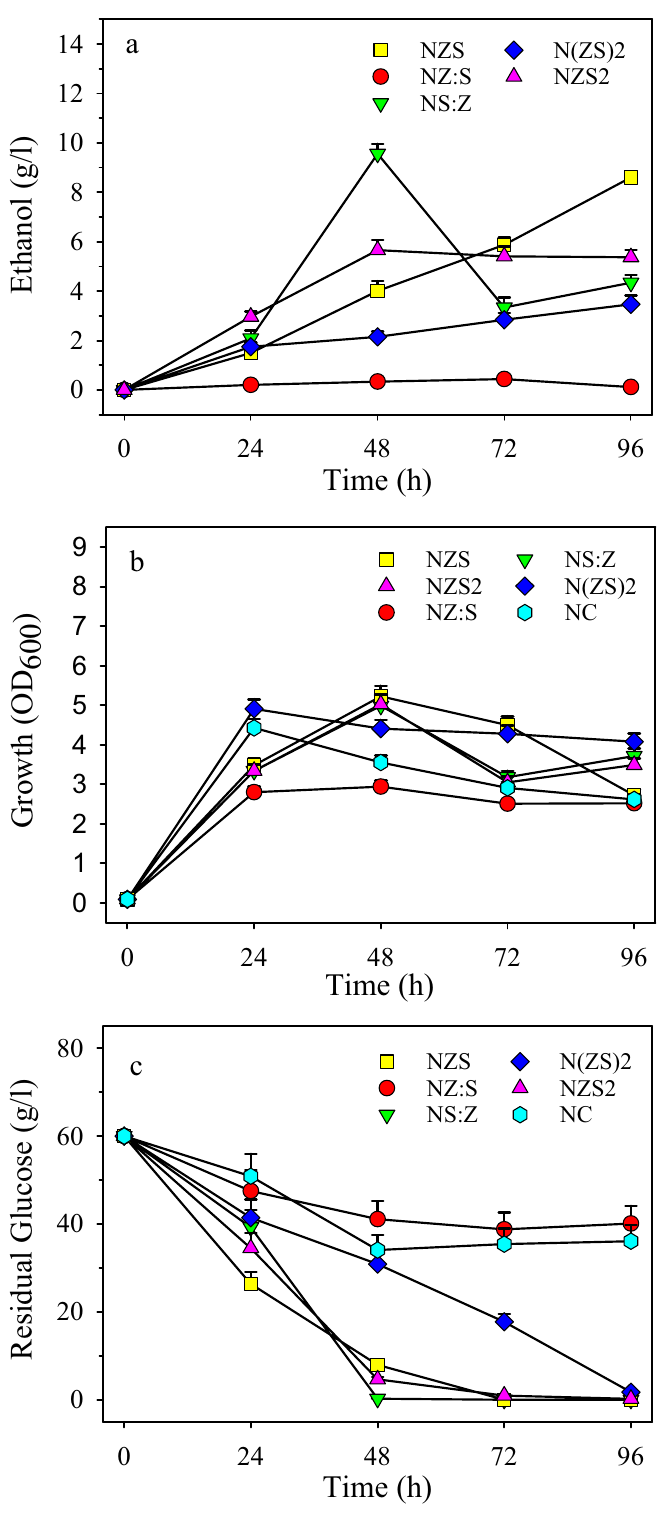
Figure 6. Ethanol production by B. subtilis strains harboring different numbers of pdc Z and adh S as well as fusions of the genes. Strains NZS (Δ ldh , pdc Z -adh S ), N(ZS)2 (Δ ldh , ( pdc Z -adh S ) 2 ), NZS2 (Δ ldh , pdc Z - ( adh S ) 2 ), NZ:S (Δ ldh , pdc Z : adh S ), and NS:Z (Δ ldh , adh S : pdc Z ) containing, respectively, one copy of each gene, two copies of each gene, one pdc Z but two adh S , adh S fused to pdc Z , and pdc Z fused to adh S , were cultured with an initial optical density of 0.1 (600 nm) in 2YT mediums supplemented with 60 g/L glucose and incubated at 37 °C, 180 rpm. Samples taken at 24-h intervals were analyzed for: ( a ) ethanol production, ( b ) cell growth, and ( c ) glucose